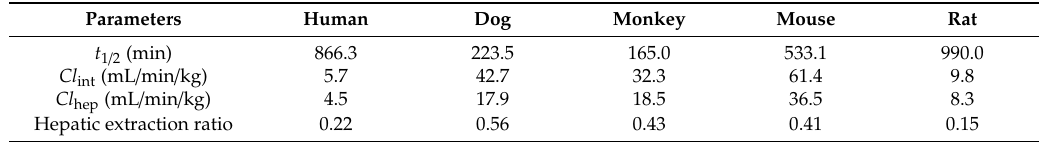
Table 1. Half-life ( t 1 / 2 ), intrinsic clearance ( Cl int ), hepatic clearance ( Cl hep ), and hepatic extraction ratio values of DWP16001 in human, dog, monkey, mouse, and rat hepatocytes. Parameters Human Dog Monkey